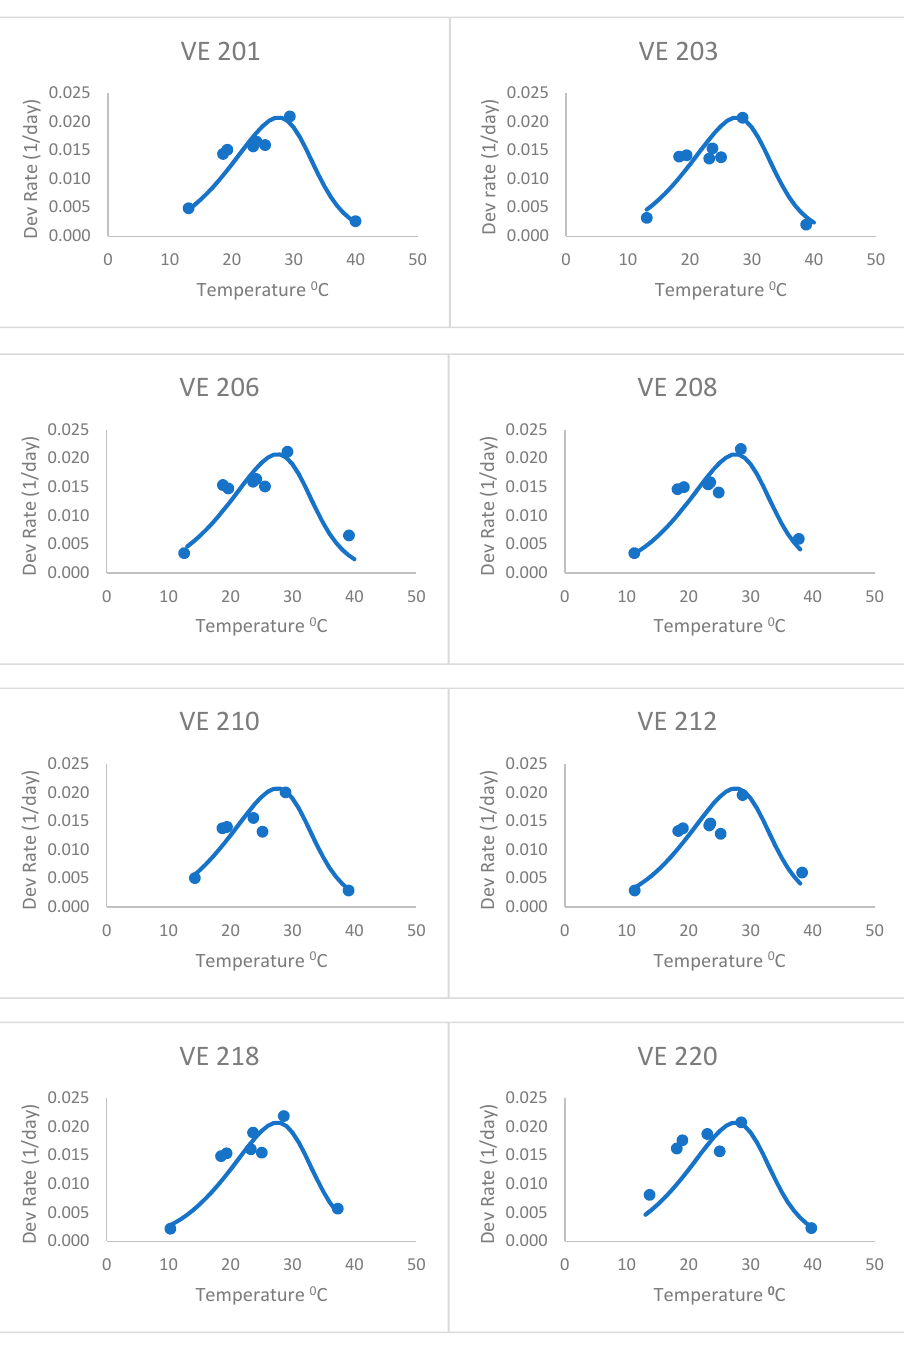
Figure 2. Poikilotherm equation fit to the first variety (VE 201) and applied to all varieties. The heat stress equation (Figure 3), with an 8 °C base temperature and forced through the optimum and highest data point for the first variety, did better than the Poikilotherm equation. The heat stress equation had lower values of RMSE and AICc than the Poikilotherm equation (Table 2). This was fitted only